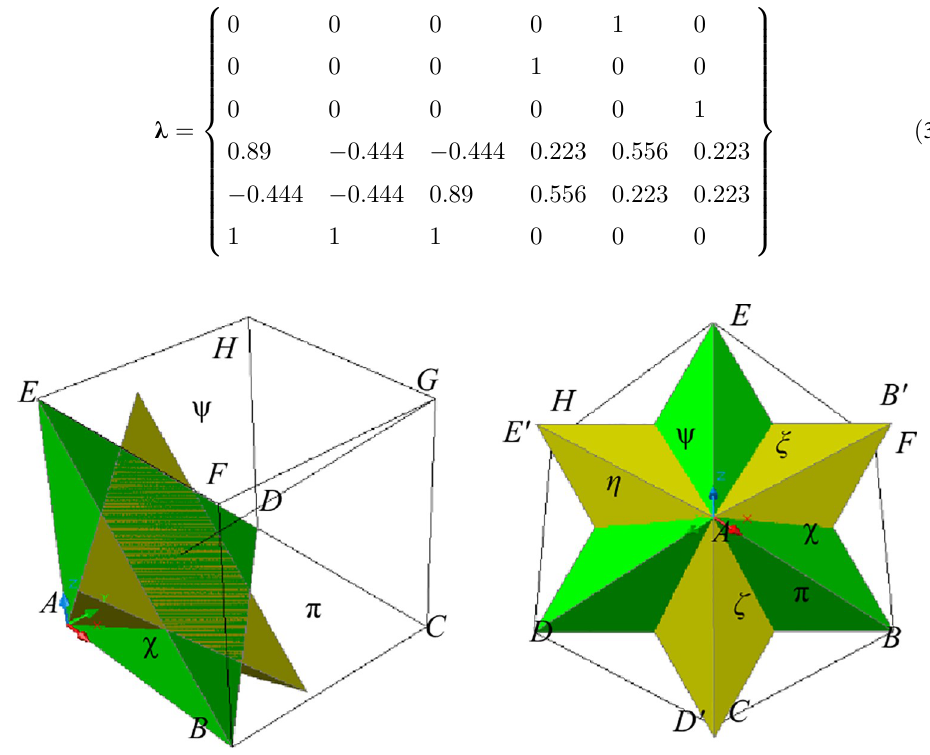
Fig 8. Right-angled tetrahedron and rotated right-angled tetrahedron. (a)Lateral view. (b)vertical view.